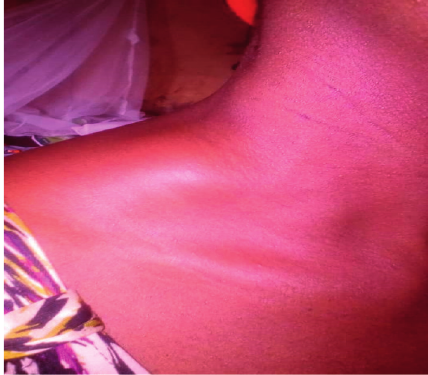
2: Ulceration of neck mass.